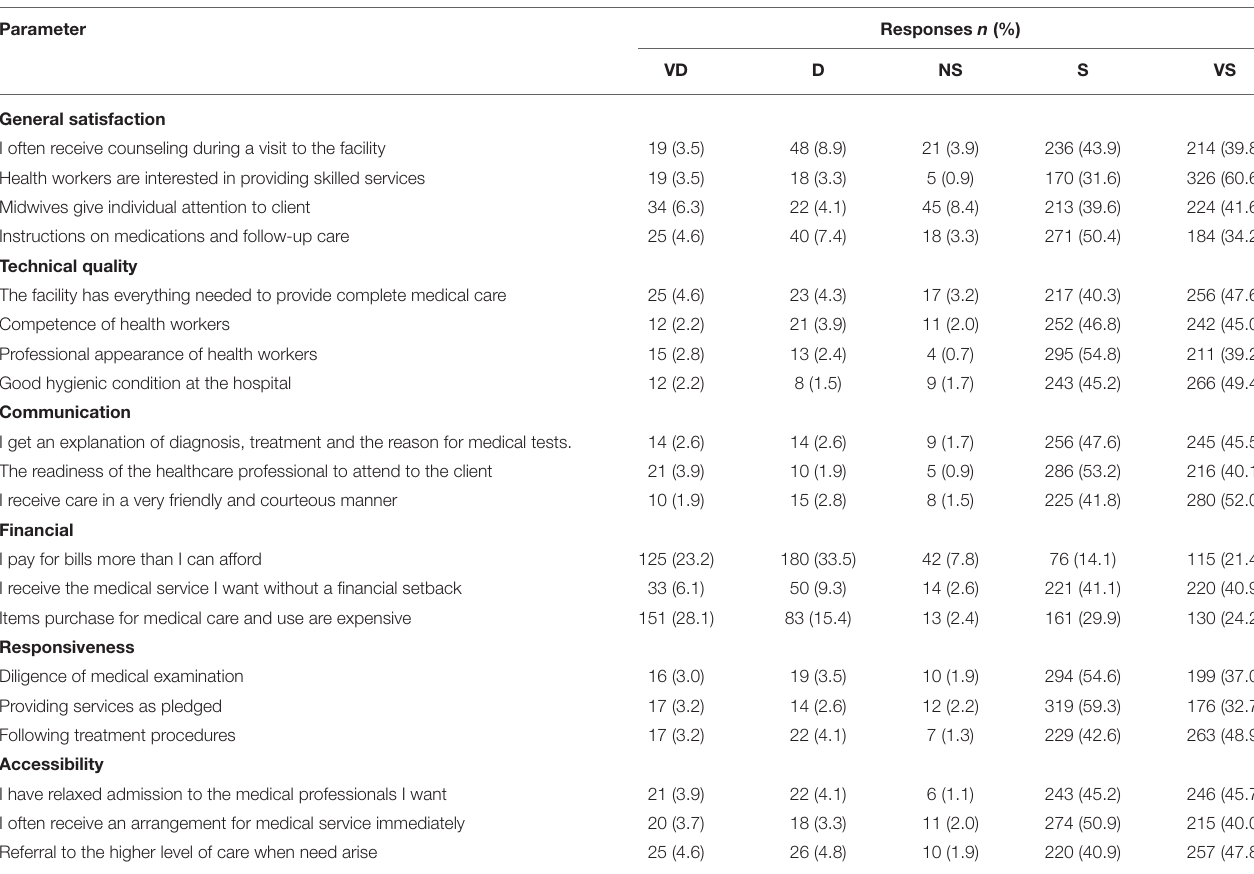
TABLE 2 | Multiple dimensions of satisfaction of postpartum mothers with skilled delivery ( n =